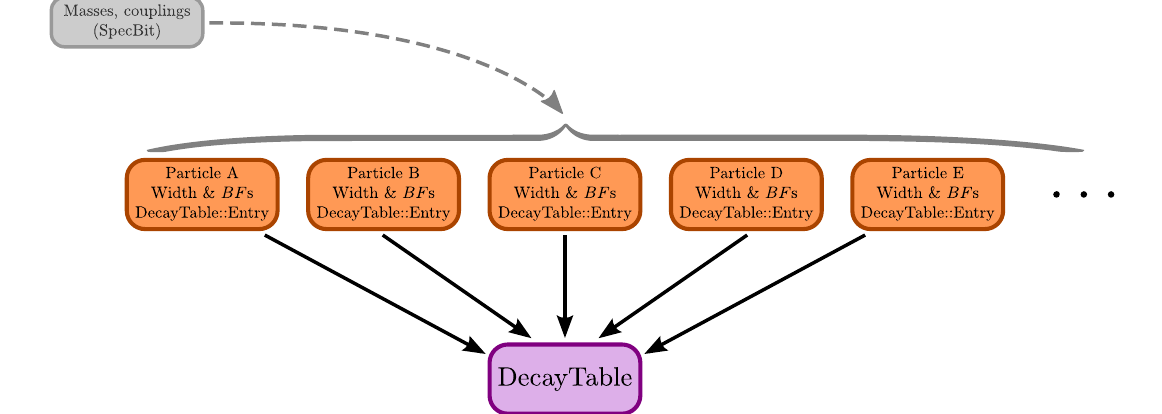
DecayTable::Entry for each particle (orange boxes). These are then collected into a single GAMBIT DecayTable (purple box), con- taining all decays of the entire spectrum, and eventually passed on to other GAMBIT